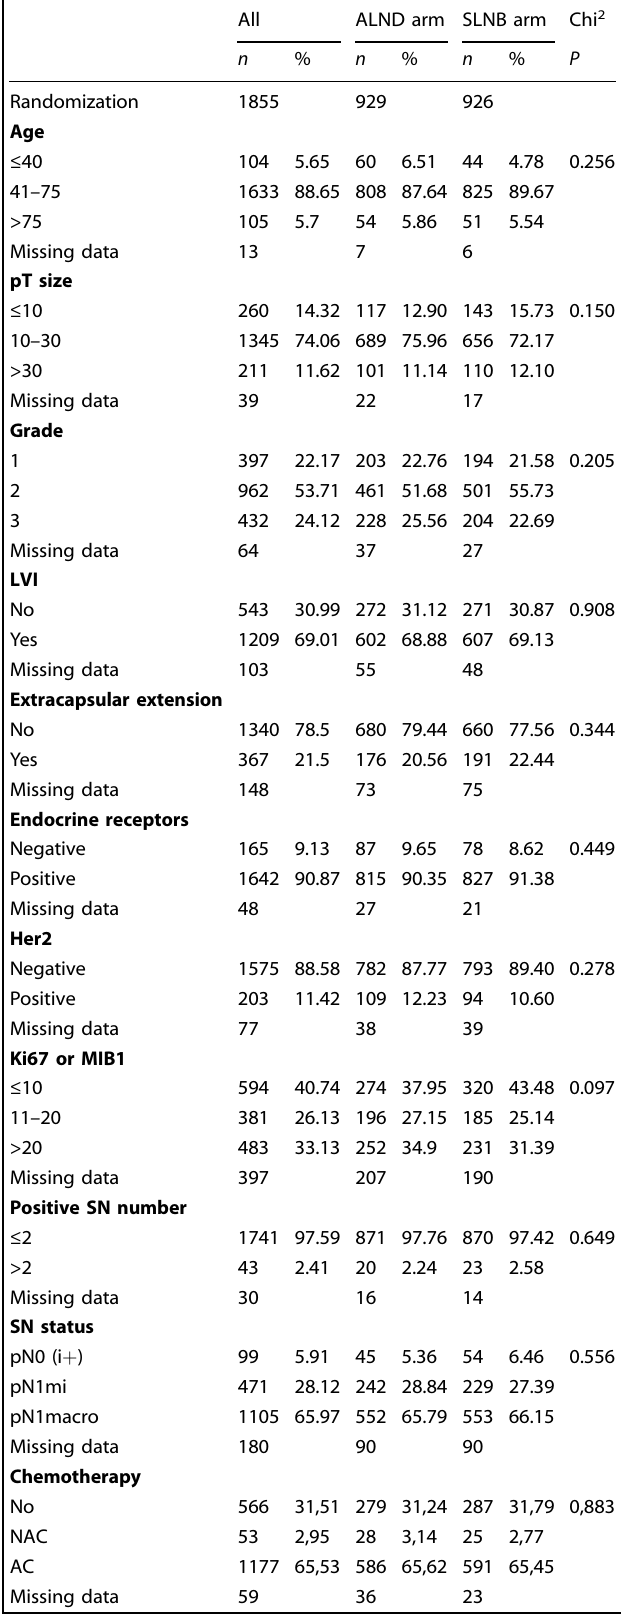
Table 1. Characteristics of patients according to arms of randomization.